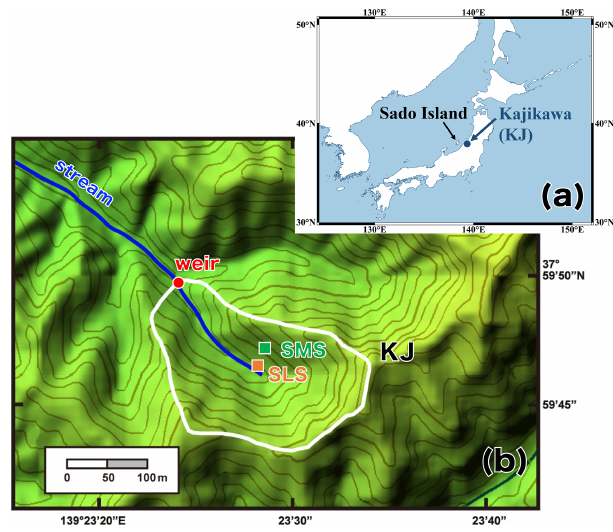
Figure 1. A map showing the locations of the studied Kajikawa (KJ) catchment in Japan (a) and a colored altitude map of the KJ catchment (b) (modified after Nakagawa et al., 2018). The white line denotes the whole catchment area, and the red circle denotes the position of the weir where the stream water was sampled. The orange (SLS) and green (SMS) squares denote the sampling stations of soil water in the riparian and upland zone, respectively, in the past study (Nakagawa et al.,